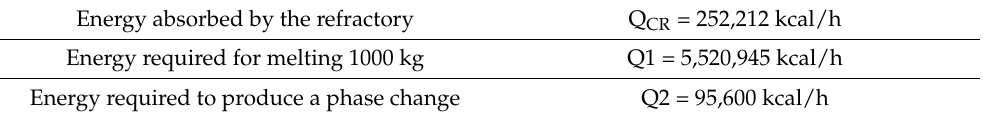
Table 3. Values of the energy absorbed by the refractory concrete.